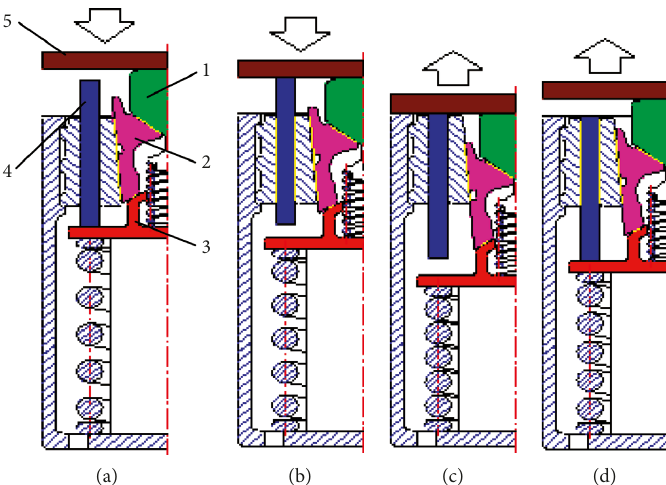
Figure 1: Working principle of MT-2 draft gear. (a) Loading phase I. (b) Loading phase II. (c) Unloading phase I. (d) Unloading phase II.1, center wedge; 2, wedge; 3, centering spring seat; 4, moving plate; 5, slave plate.